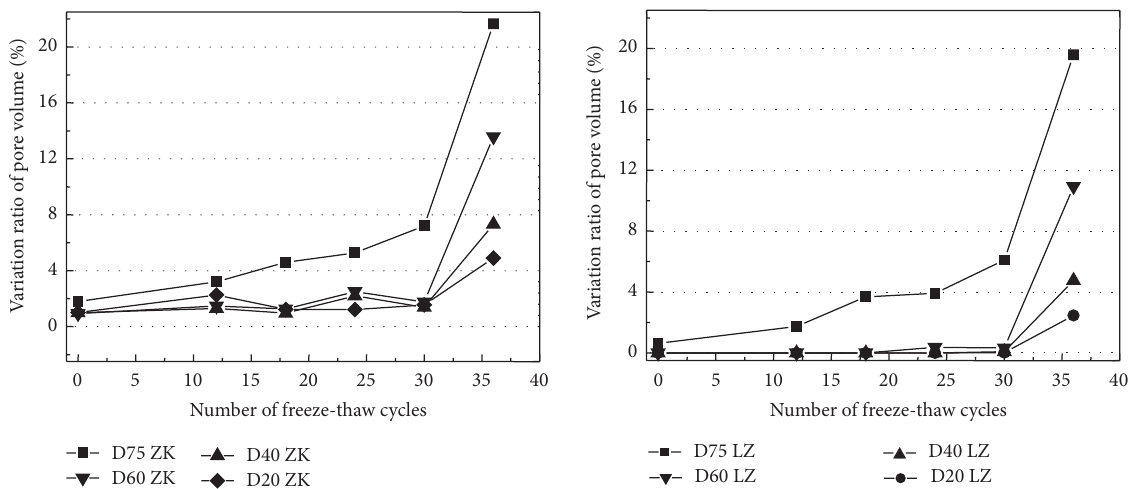
Figure 4: Variation ratio of concrete porosity along with the number of freeze-thaw cycles.